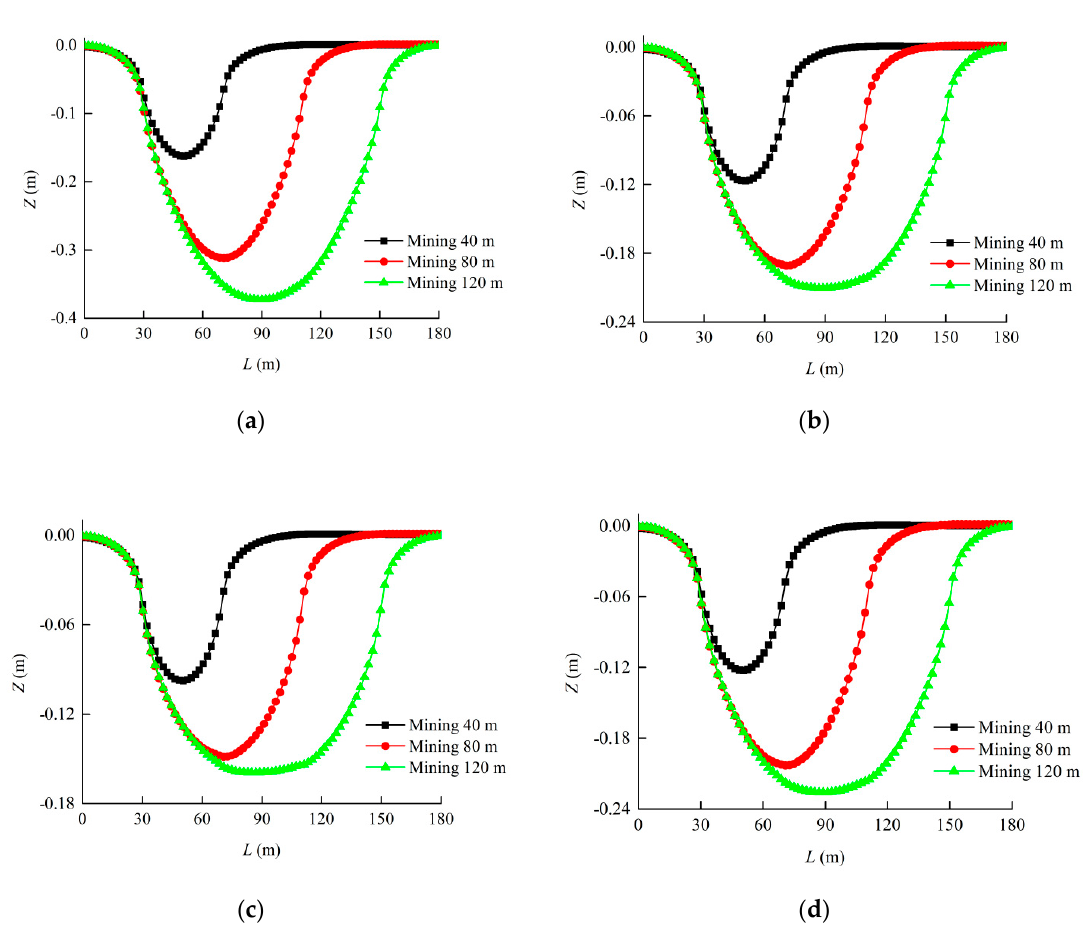
Figure 12. Subsidence displacement of the coal seam roof at different mining distances when the goaf was filled with cemented rockfill with different granule gradations. n = 0.2 ( a ); n = 0.4 ( b ); n = 0.6 ( c ); and, n = 0.8 ( d ).